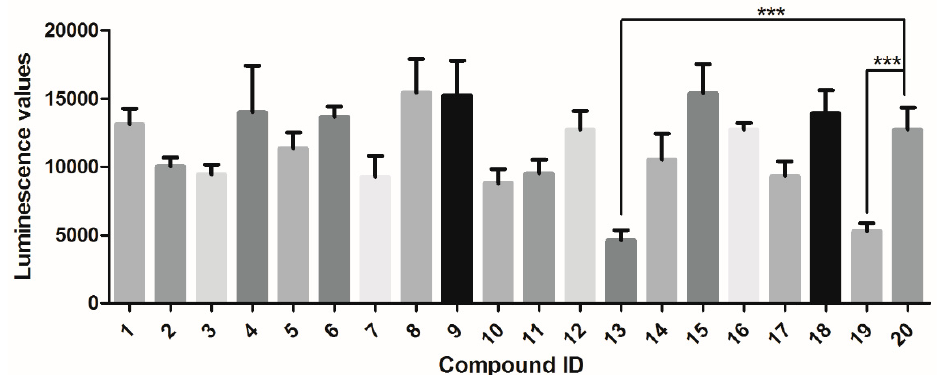
Figure 3. The luminescence values of the Syk solution after incubation with 18 test compounds in ADP-Glo TM kinase assays. The luminescence value was detected in the presence of 1 ng/ μ L Syk incubated with 18 compounds (30 μ M in the total reaction system) using an ADP-Glo TM kinase assay kit for primary screening. Information about compounds 1 to 18 can be found in Table 1. Compounds 19 and 20 represent thepositive and negative control, respectively. The error bars indicate the standard error (SE) of three replicates. *** means p < 0.001.